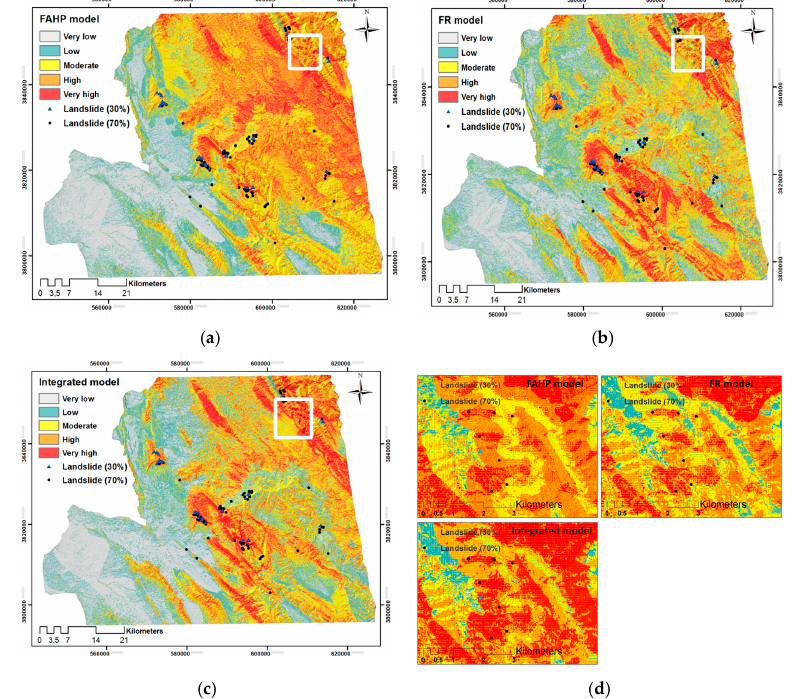
Figure 14. Landslide susceptibility map of the earthquake ‐ affected area based on three models ( a – c ) and enlarged areas ( d ).